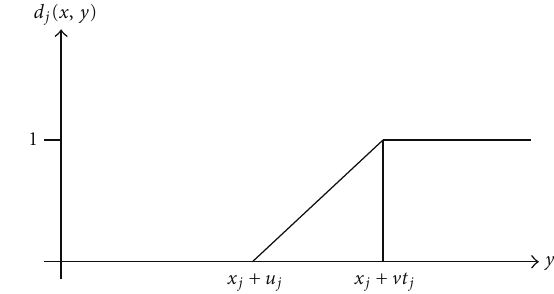
F 3: Partial discordance relation